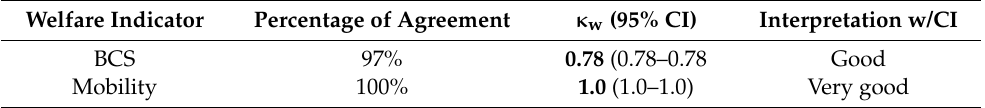
Table 2. Kappa weighted values and their 95% confidence intervals for all preliminary indicators tested for inter-observer reliability in a sample of 34 ponies. K is 1 when there was perfect agreement and 0 when there was no agreement better than chance. All κ w values of 0.61 (good) and above are shown in